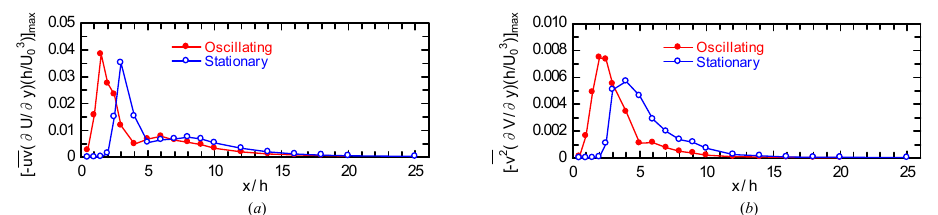
Fig. 8 Streamwise variation of maximum fluctuating energy production rates in the ( a ) streamwise and ( b ) normal components.